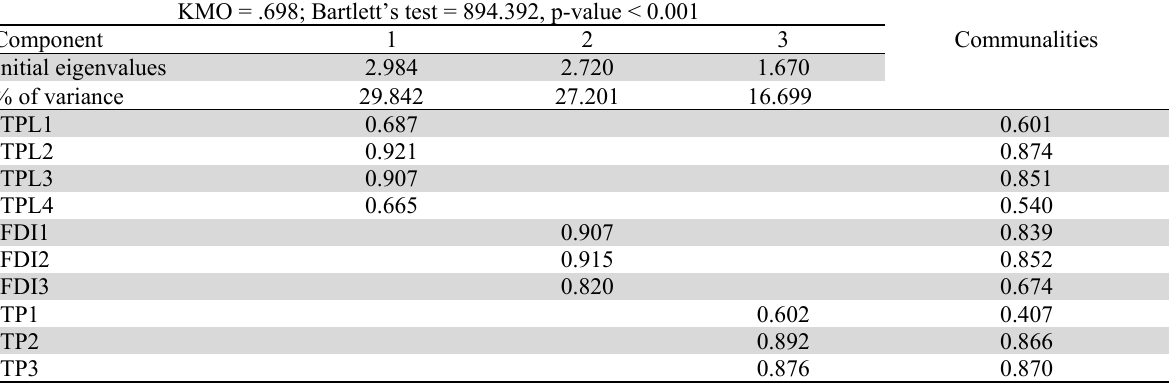
EFA Analysis result after Varimax